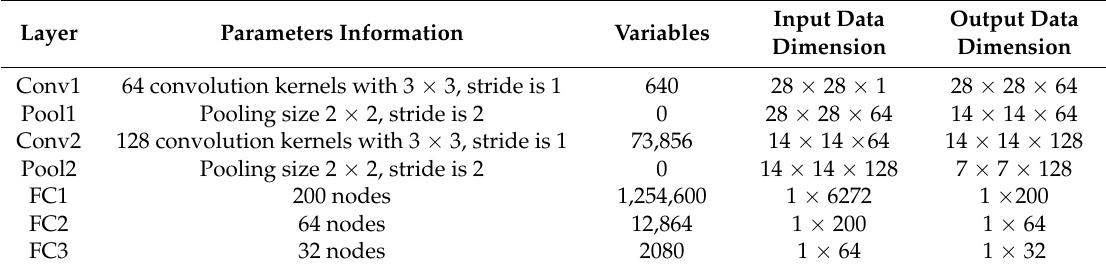
Table 1. The configurations of the convolution, pooling, and fully connected (FC) layers.